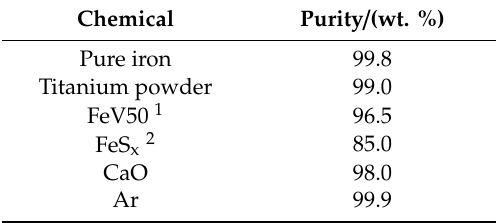
Table 1. Materials used for desulfurization experiment.